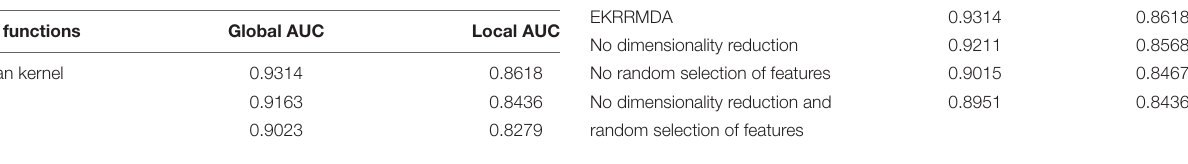
functions used in KRR, Poly(1) and Poly(2) in the literature (Exterkate et al., 2016), both of which are polynomial kernel functions and their corresponding kernel function is κ (cid:0) (cid:1) = (cid:0) (cid:1) 2 1 + x (cid:48) y and κ 1 + x (cid:48) y , respectively. The results of x , y